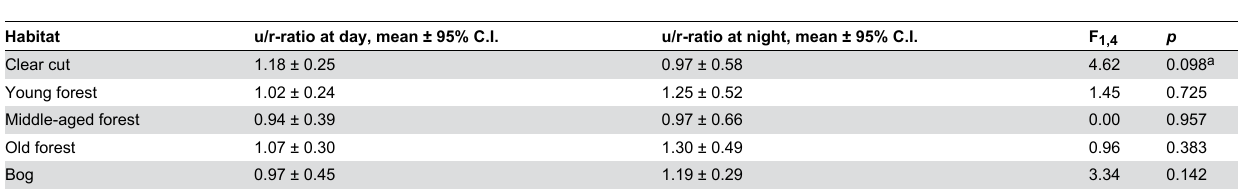
Table 1. Summary statistics for repeated ANOVAs examining whether habitat selection by roe deer at the spatial and temporal scales of home ranges and seasons differed between day (08:00–18:00) and night (18:00–08:00) at Grimsö Wildlife Research Area in 1994 and 1999.